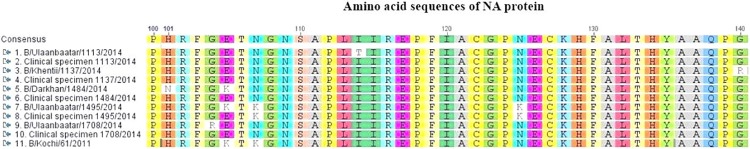
The compared result of drug resistant strains, NA protein sequences with clinical specimens and strain B/Kochi/61/2011.